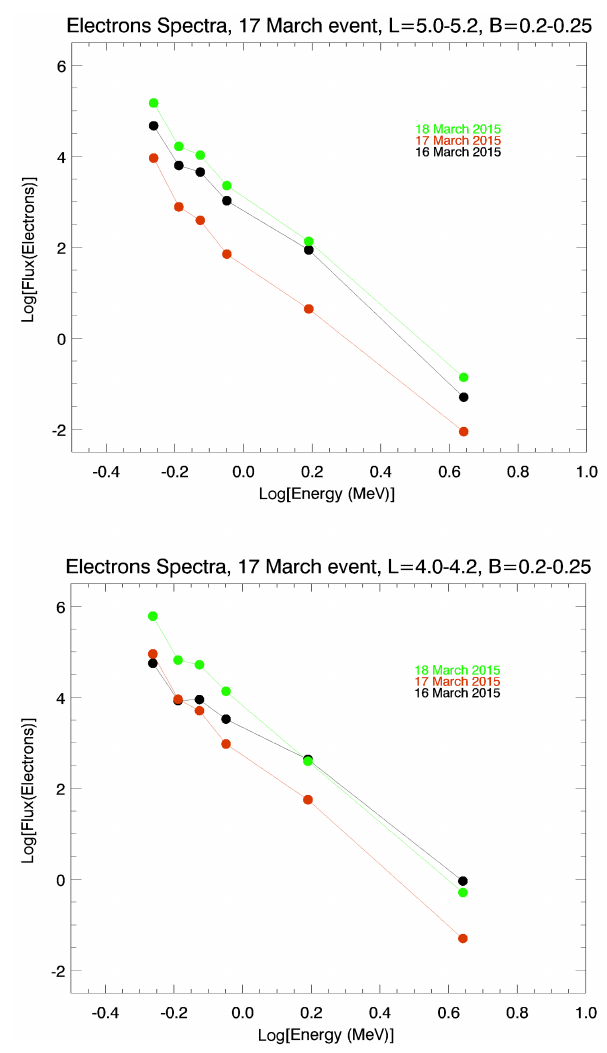
Figure 7. Spectra for two different ( L , B ) bins observed by EPT on 16, 17 and 18 March 2015, corresponding respectively to the day before, during and after the storm. The upper panel shows the bin L = 5.0–5.2, B = 0.2–0.25. The lowest fluxes are observed during the storm, but for the 3days, the spectra shape is the same. The bottom panel shows the bin L = 4.0–4.2, B = 0.2–0.25. For this bin, 17 March has also the lowest fluxes, but only the energies >800keV show a dropout.